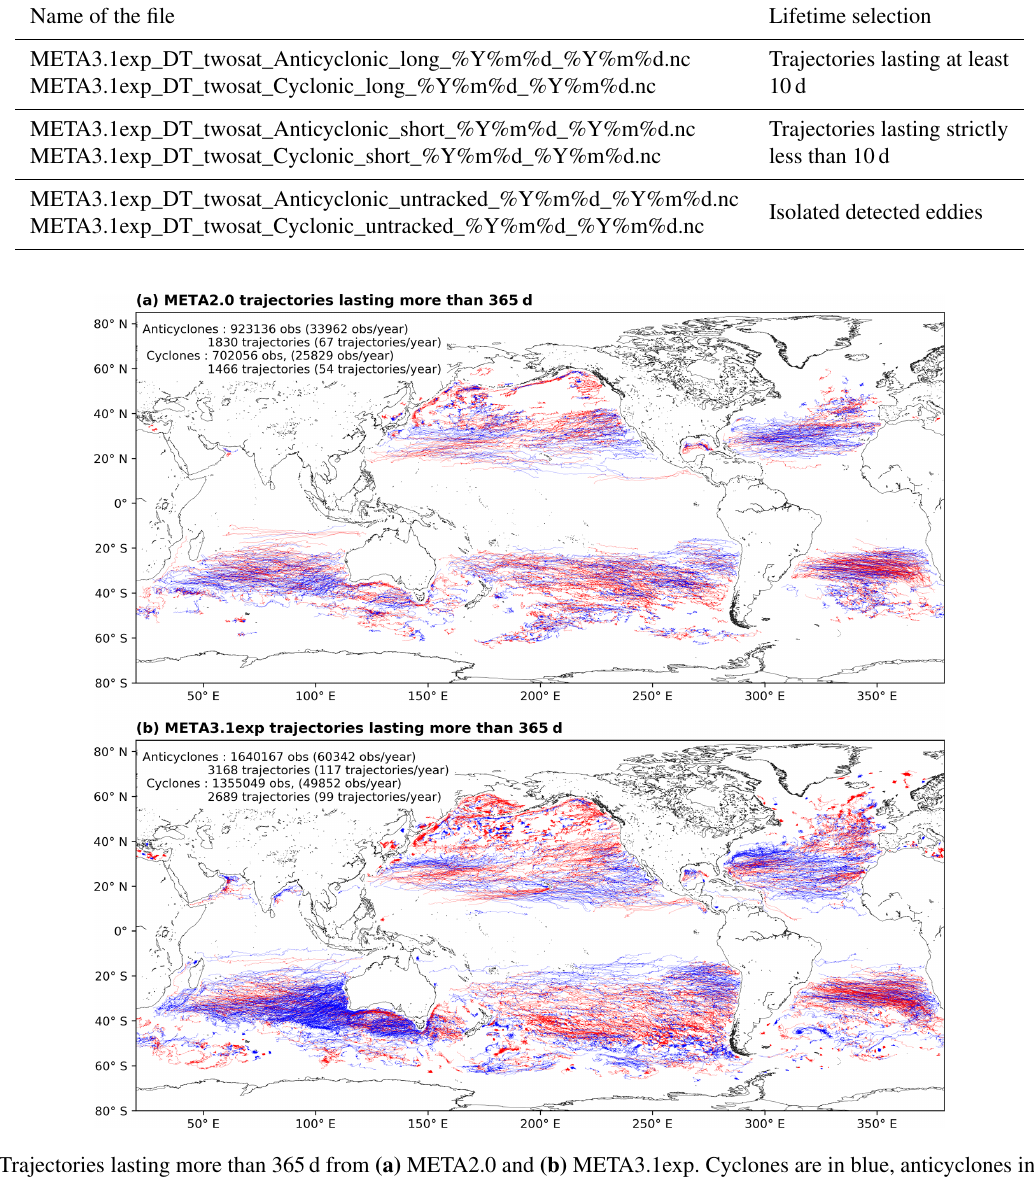
Note that each threshold and parameter (input maps, cutoff wavelength, amplitude, shape error, number of pixels, trajec- tory lifetime) used to produce the META3.1exp datasets can be adapted by the users if they found the datasets not suitable for their study. The flexibility of the detection and tracking schemes is a strong advantage of the py-eddy-tracker pack-